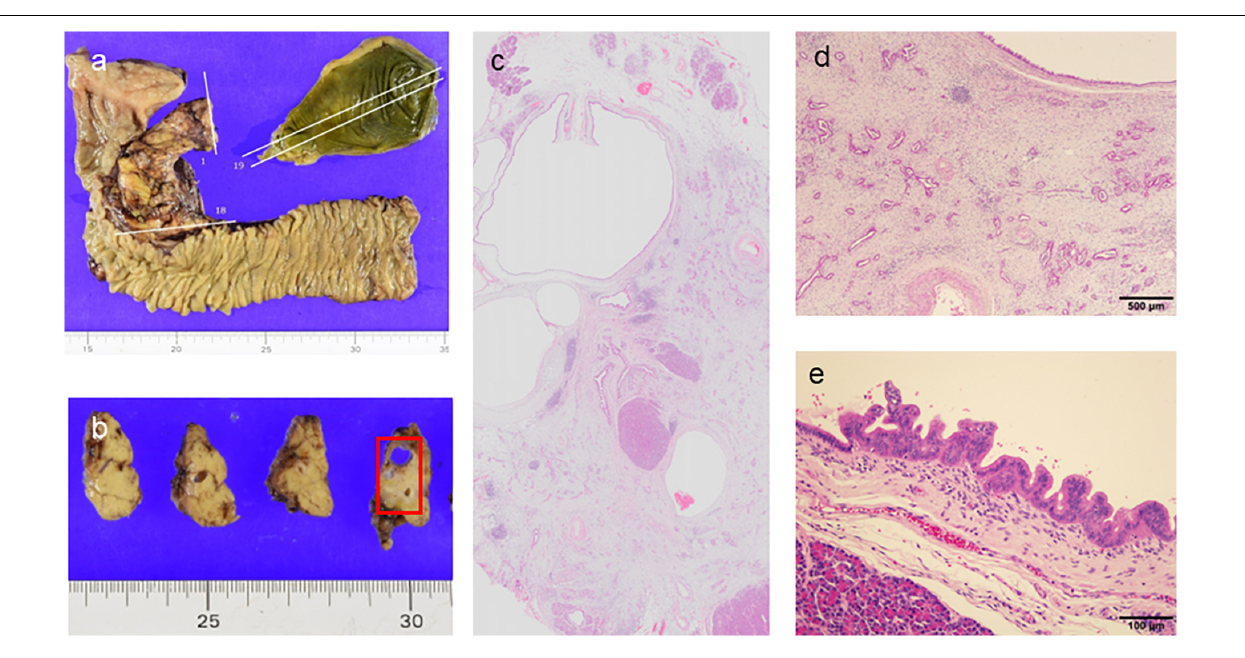
FIGURE 5 | Pathological findings of the pancreato-duodenostomy specimen. (a,b) Macroscopic findings. (c) Loupe view showing ductal adenocarcinoma concomitant with high-grade intraductal papillary mucinous neoplasm (IPMN) (hematoxylin and eosin [HE] stain). (d) Moderately-differentiated ductal adenocarcinoma with fibrous stroma (HE, × 40). (e) Intraepithelial carcinoma arising in the IPMN component (HE, ×